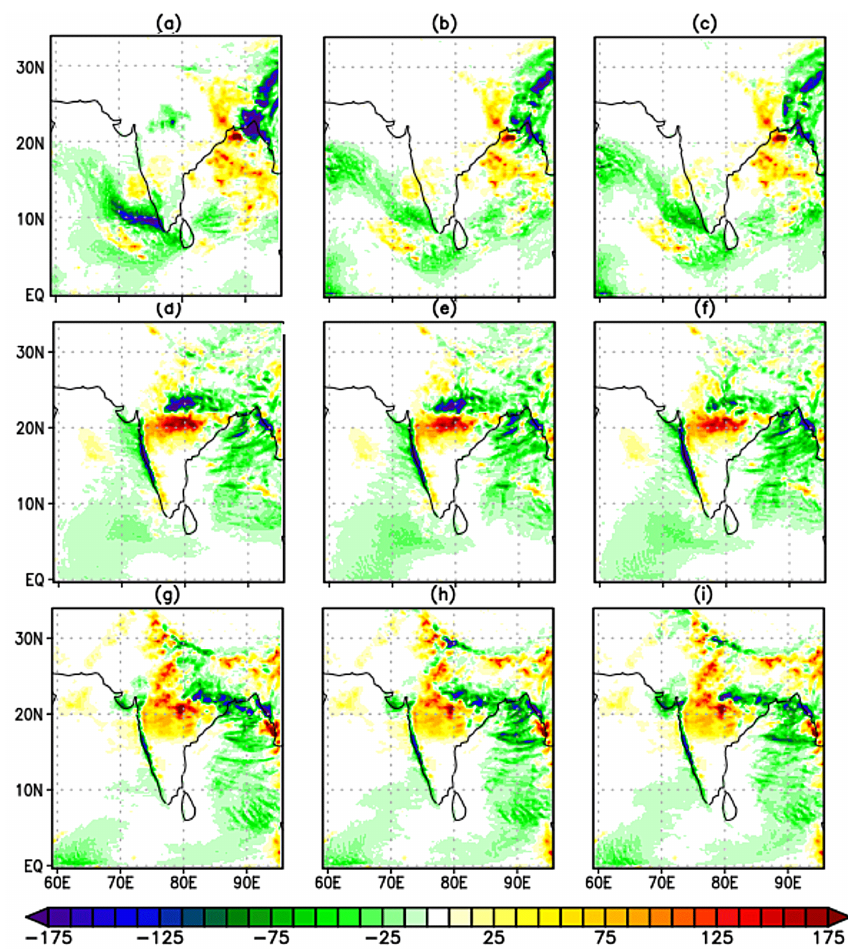
Figure 8. Differences in 48h accumulated precipitation (in mm) from TRMM rainfall observation for case 1 (a–c) , case 2 (d–f) and case 3 (g– i) for the CTRL (a, d, g) , cv5 (b, e, h) and cv6 (c, f, i) runs.